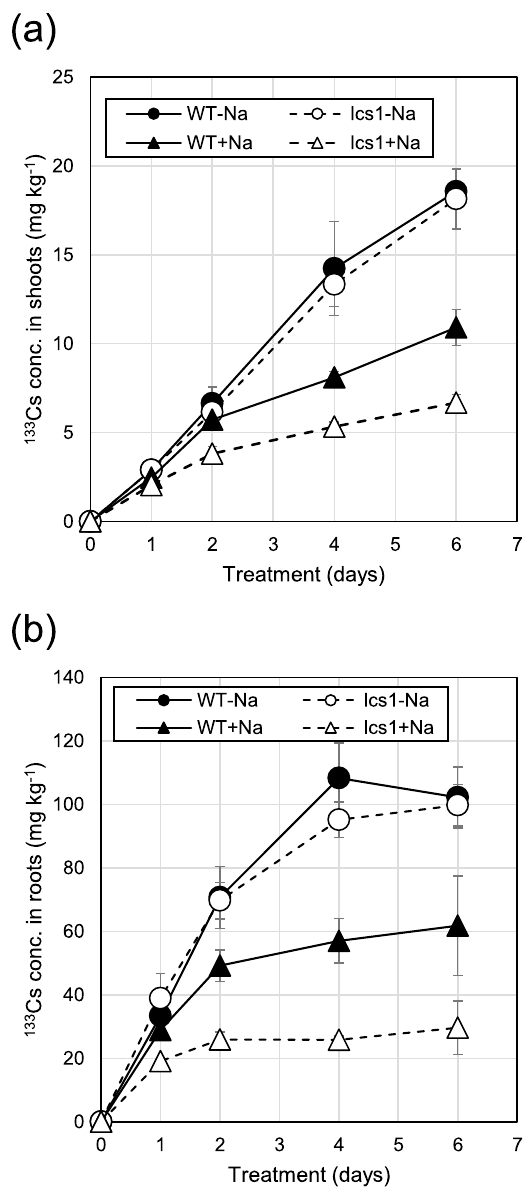
Figure 4. Time course of 133 Cs concentrations in ( a ) shoots and ( b ) roots of WT and lcs1 . Plants were treated with nutrient solution containing 0.1 µ M Cs + in the presence ( + Na + ) or absence ( − Na + ) of 10 mM Na + under low-K + (0.05 mM) conditions. Data are means ± SD of three biological